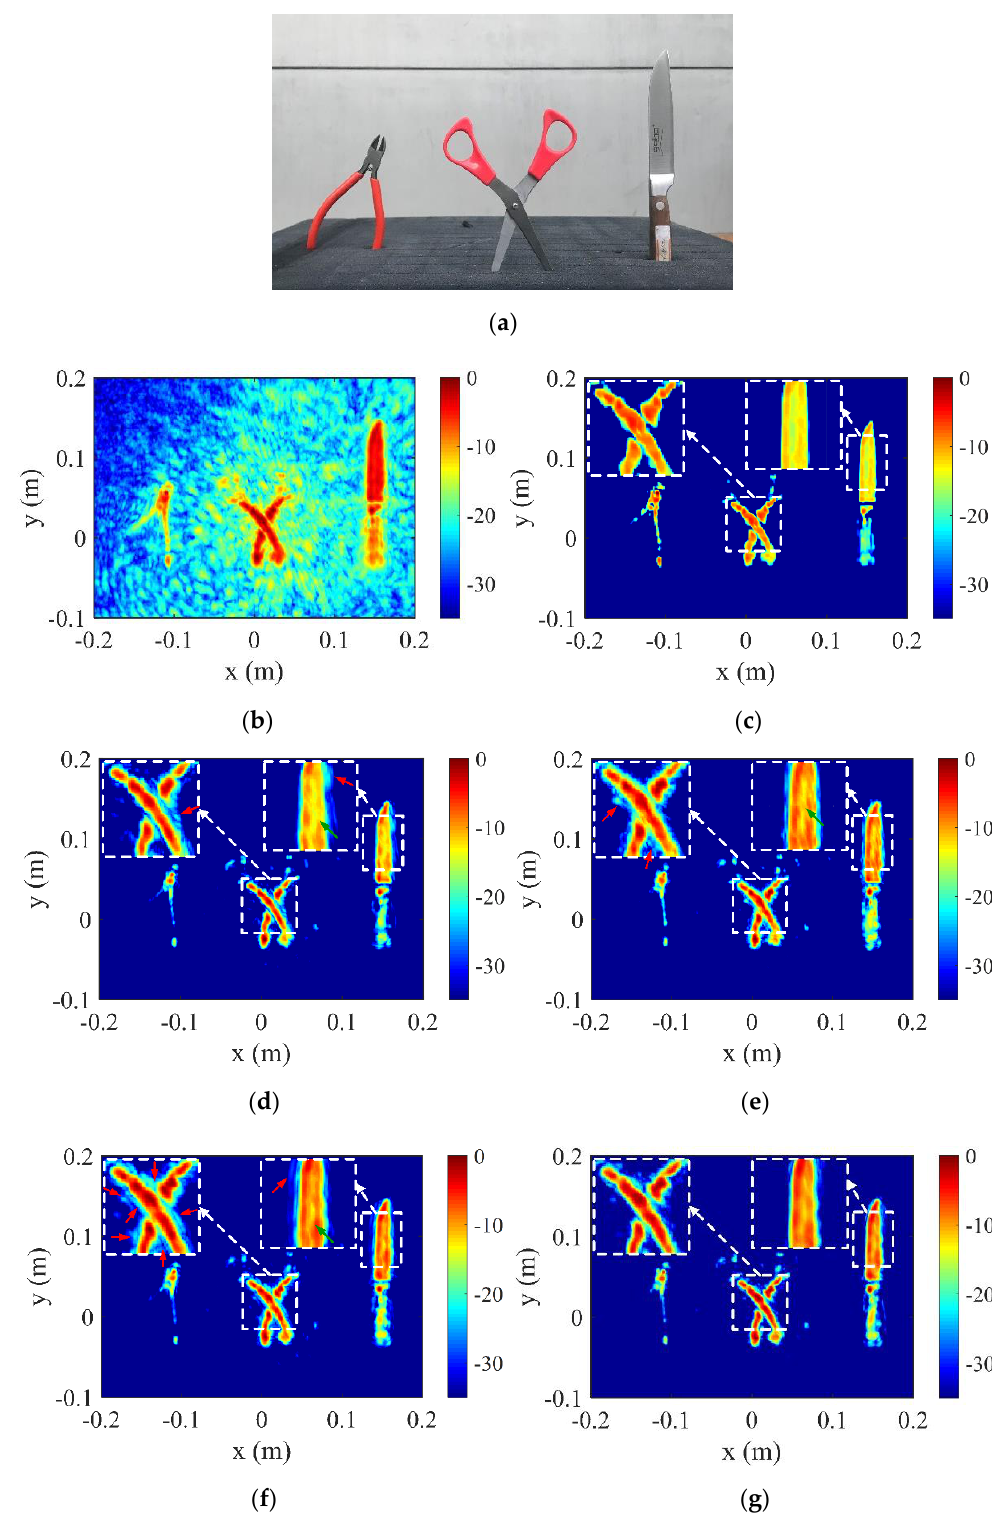
Figure 6. Images showing the 2-D images using 50% of data: ( a ) the measured targets; ( b ) image via PSM; ( c ) image via CS; ( d ) image via RVFCNN (PReLU); ( e ) image via CVFCNN (CReLU); ( f ) image via CVFCNN (CPReLU 1 ); ( g ) image via CVFCNN (CPReLU 2 ).